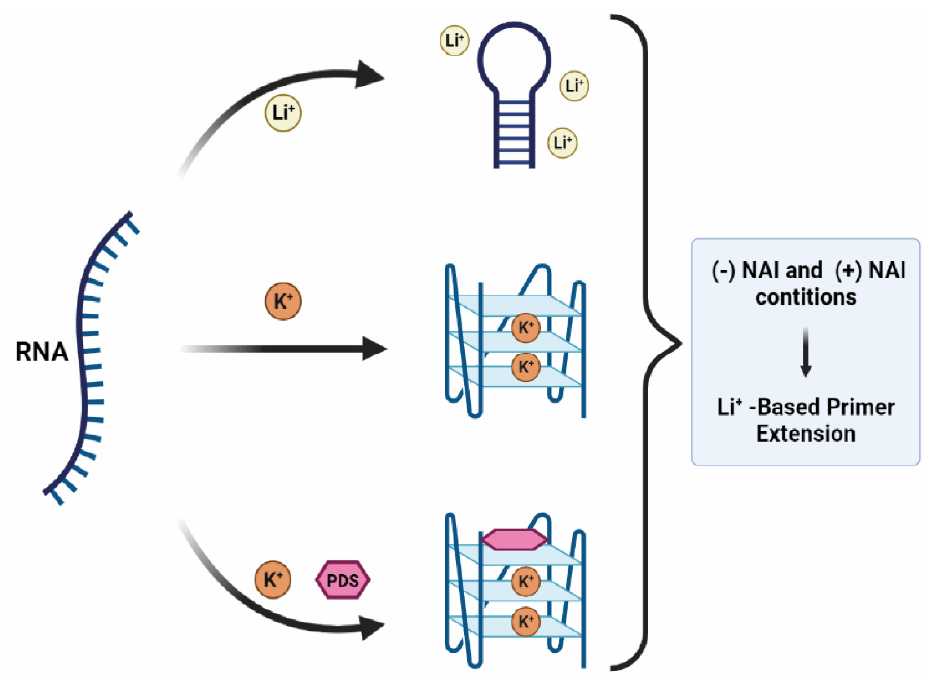
Figure 7. Representation of SHALiPE method [57]. Copyright (2016), with permission from Wiley.